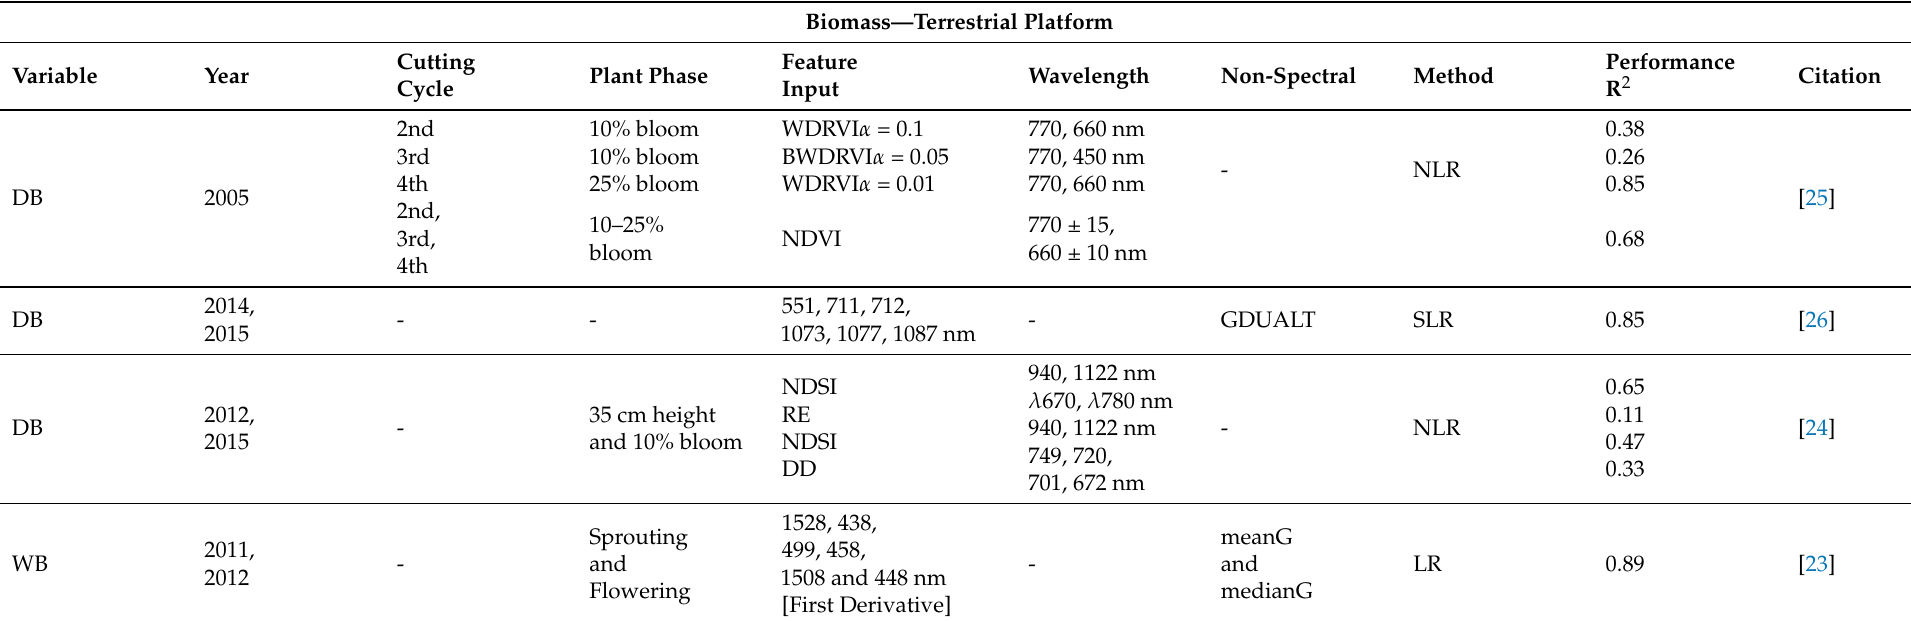
Table A1. Most accurate features for predicting alfalfa biomass using terrestrial